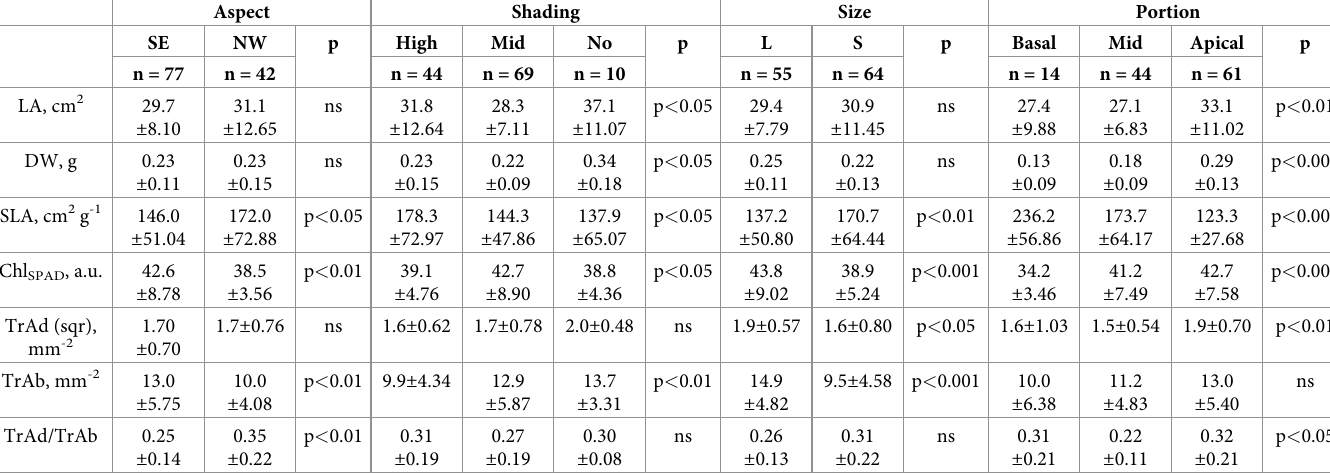
Table 1. Mean values ( ± s.d.) of leaf traits (LA: leaf area; DW: dry weight; SLA: specific leaf area; Chl SPAD : chlorophyll content measured with the chlorophyll meter SPAD; TrAd: adaxial trichomes density; TrAb: abaxial trichomes density; TrAd/TrAb: ratio between adaxial and abaxial trichomes density) sorted for site specific (aspect, shading) and plant (size, portion) variables. The p-value after one-way ANOVA analysis is reported. Aspect Shading Size